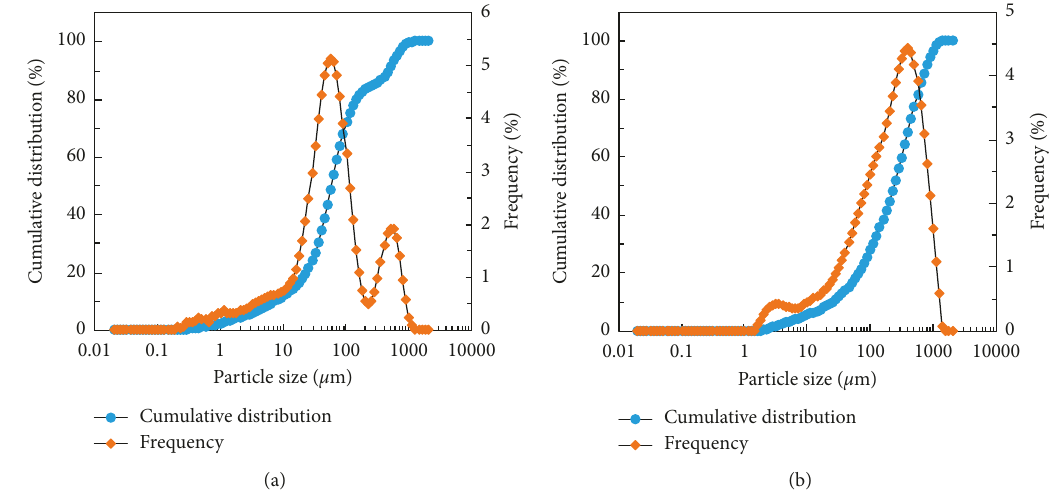
Figure 2: Curve of particle-size distribution of HPG (a) and PS